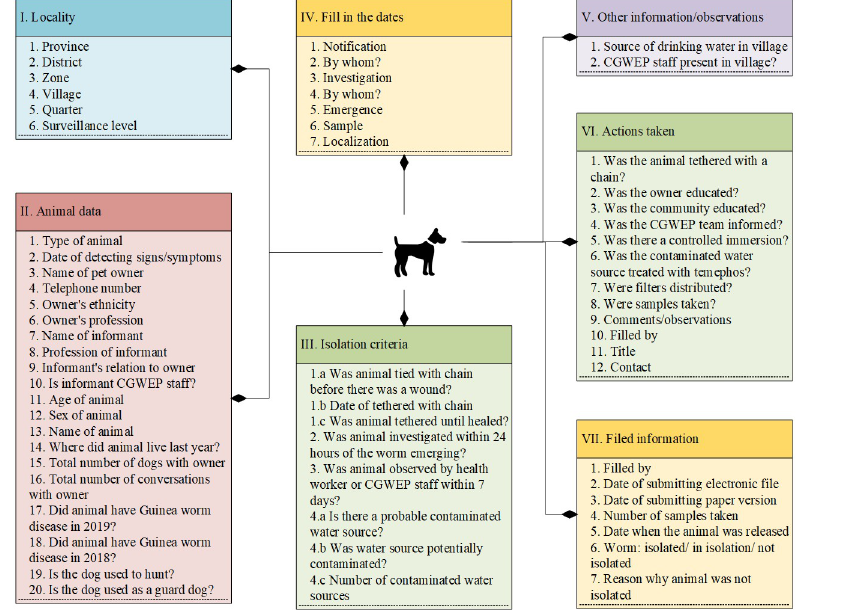
Fig 2. Form for investigating infections in